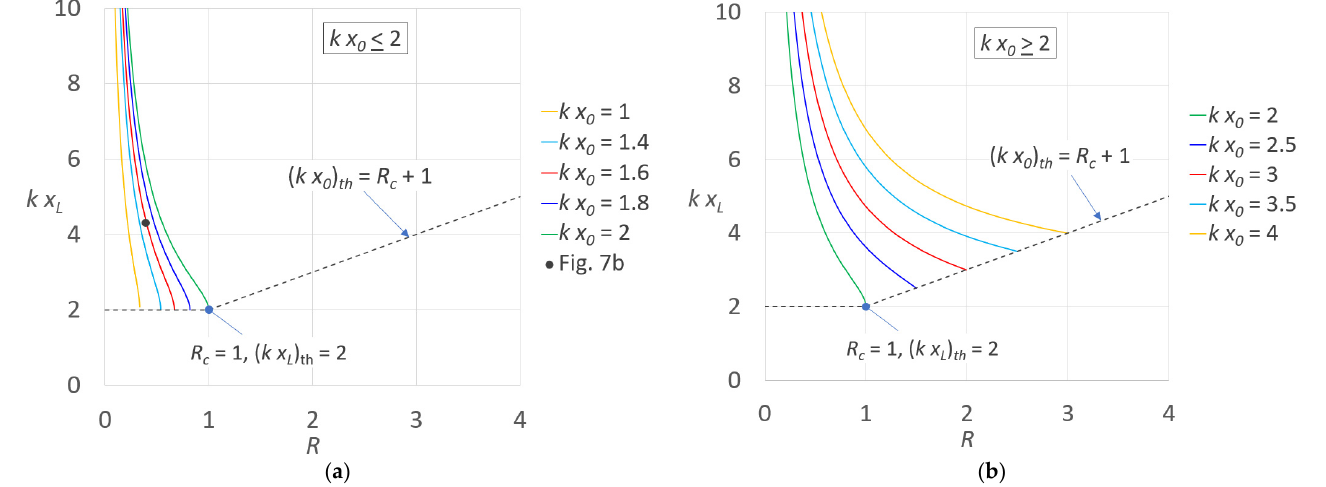
Figure 4. Dimensionless parameters k x L (Equation (29)) versus the return ratio, R , ( a ) for k x 0 ≤ 2 and ( b ) for k x 0 ≥ 2. The limiting k x L conditions (Equations (31) and (32)) are also indicated. In ( a ), the dot corresponds to the applications performed later.